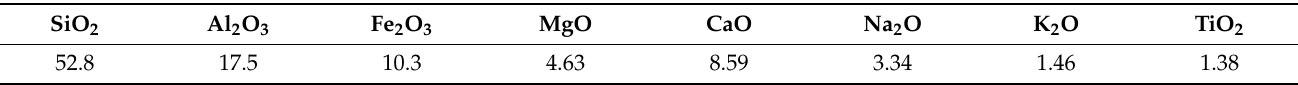
Figure 1. SEM image ( a ) and XRD pattern ( b ) of basalt fiber. Table 1. Chemical composition of basalt fiber